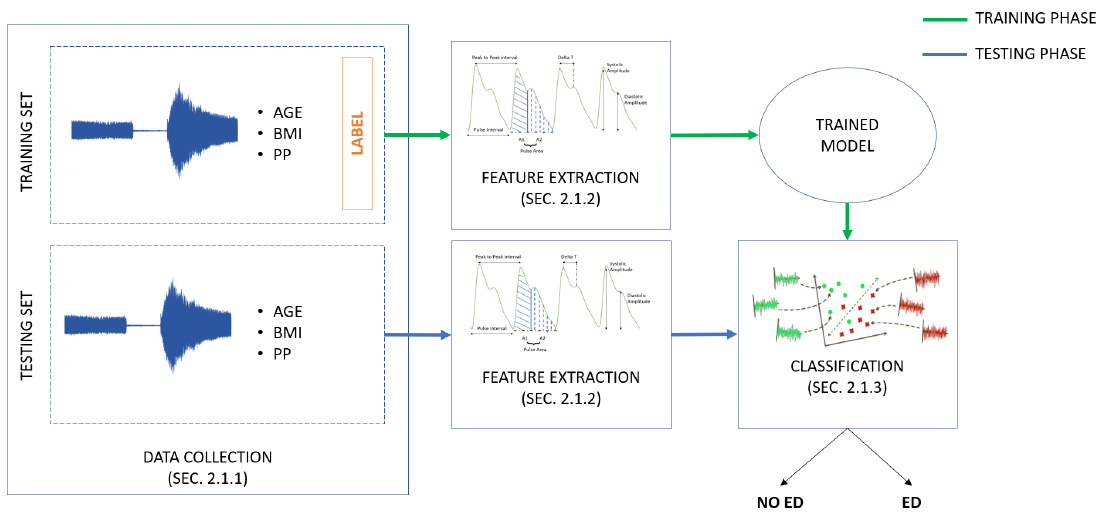
Figure 1. Workflow of the proposed learning-based approach to endothelial dysfunction (ED) screening from photoplethysmographic and anthropometric